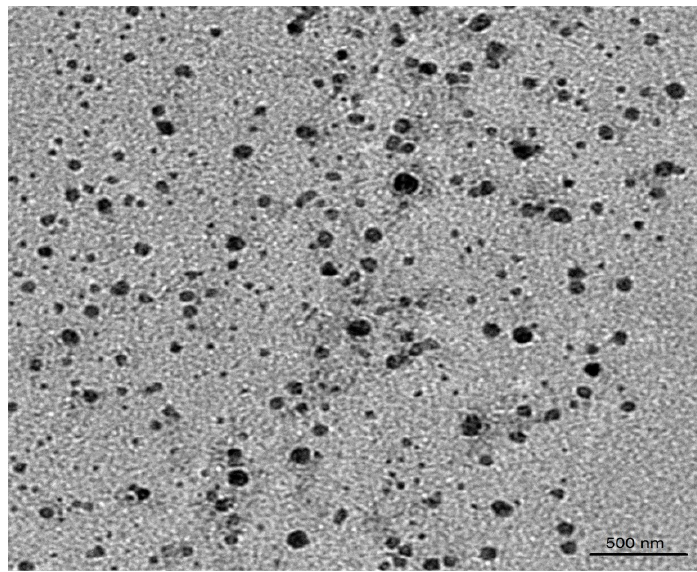
Figure 3. TEM image of β -SIT-Alg/Ch-NPs-FA.